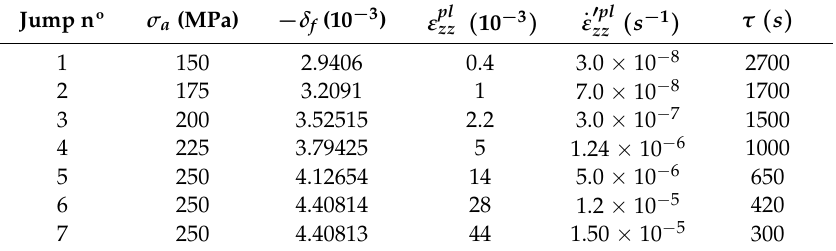
Table 1. Adjusted parameters for calculating δ ⊥ (Figure 12) of “standard”